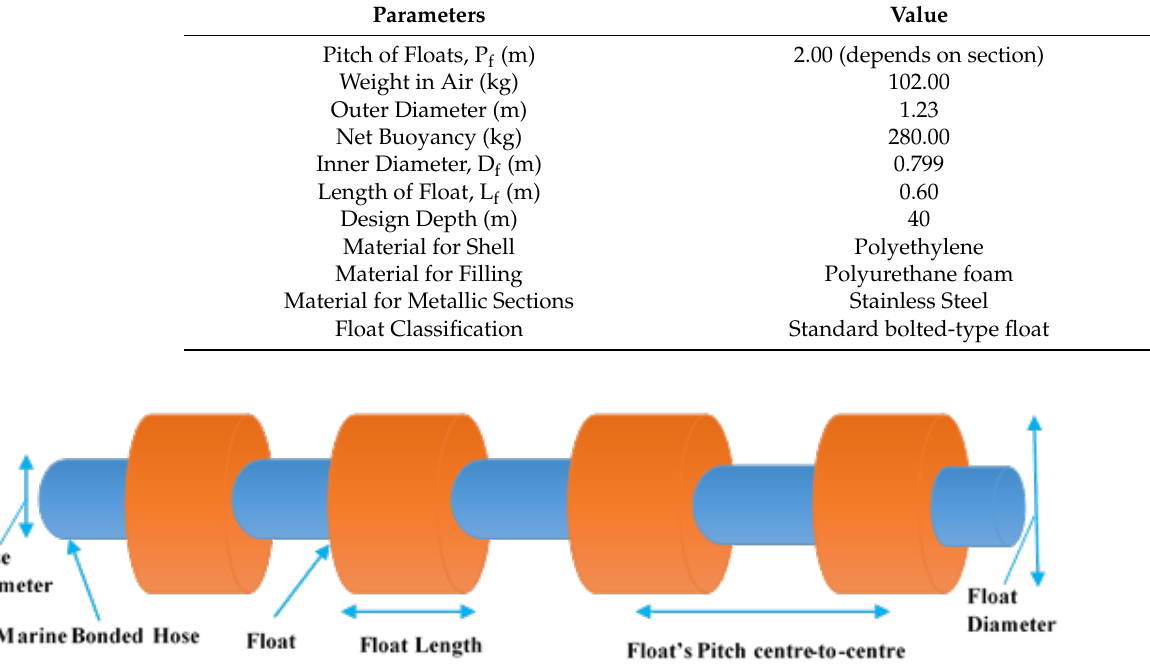
Figure 9. Typical floats attached to offshore submarine hoses .